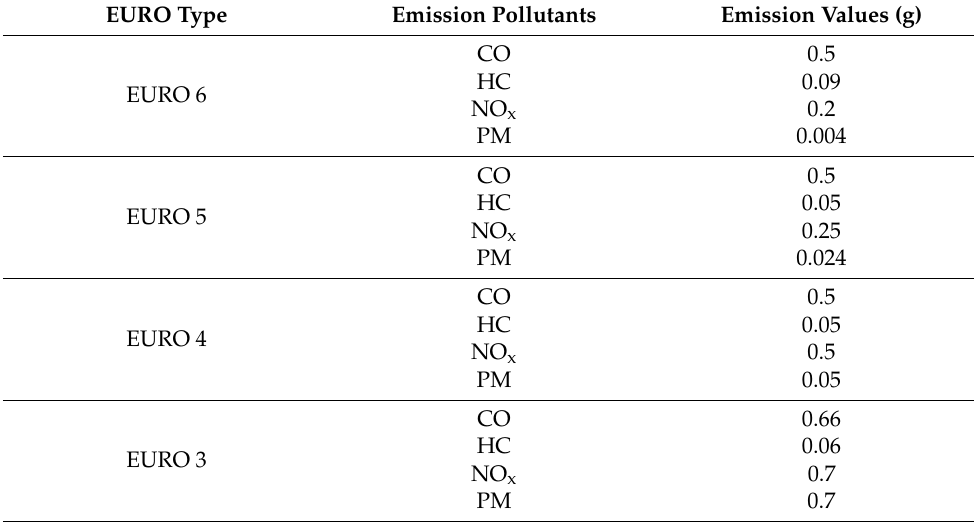
Table A2. Emissions Standards for Diesel Bus Engines [23].